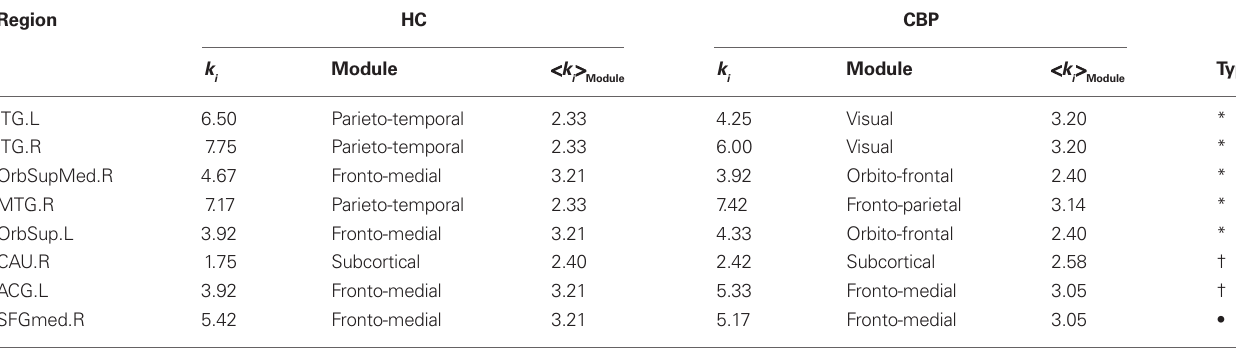
Table 2 | Changes in node’s role. region